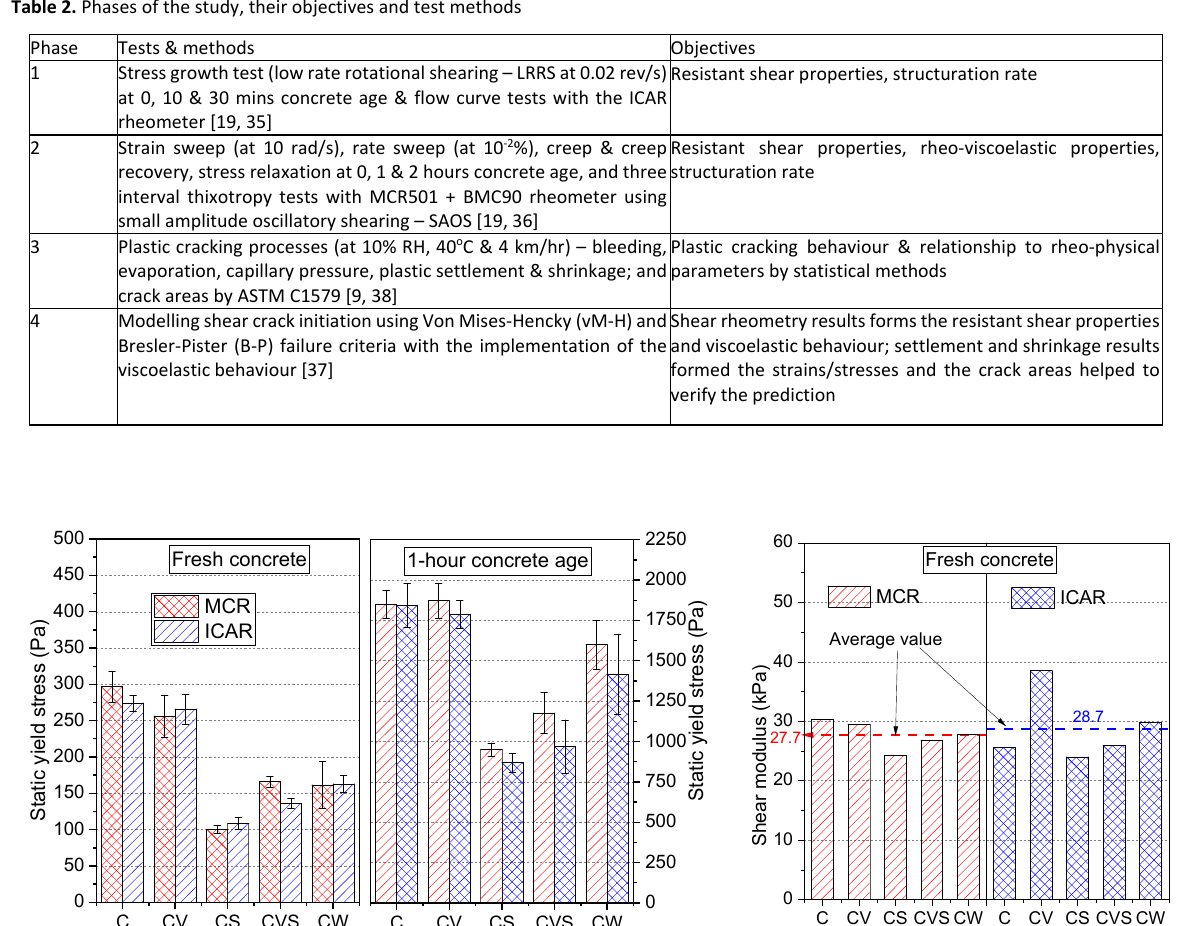
Figure 5. Relationship between results of ICAR and MCR501 rheometers at 60% reduced stone content.